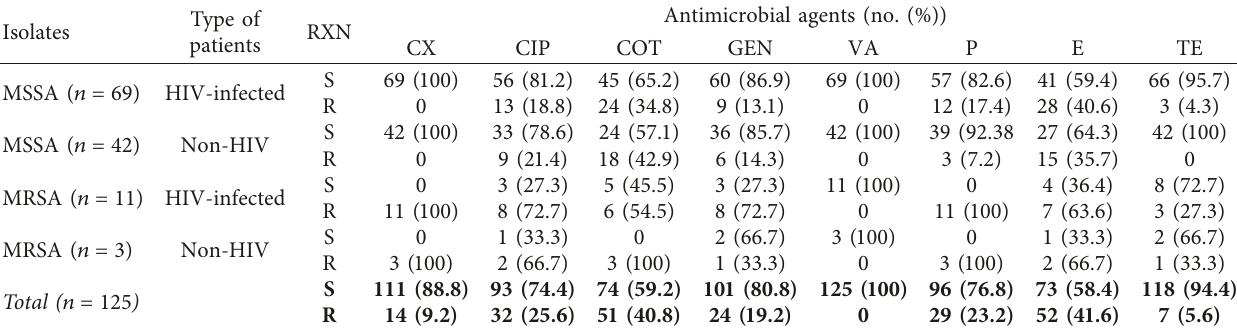
Table 3: Antibiotic susceptibility pattern of MSSA and MRSA bacteria isolated from HIV-infected and non-HIV patients. Isolates